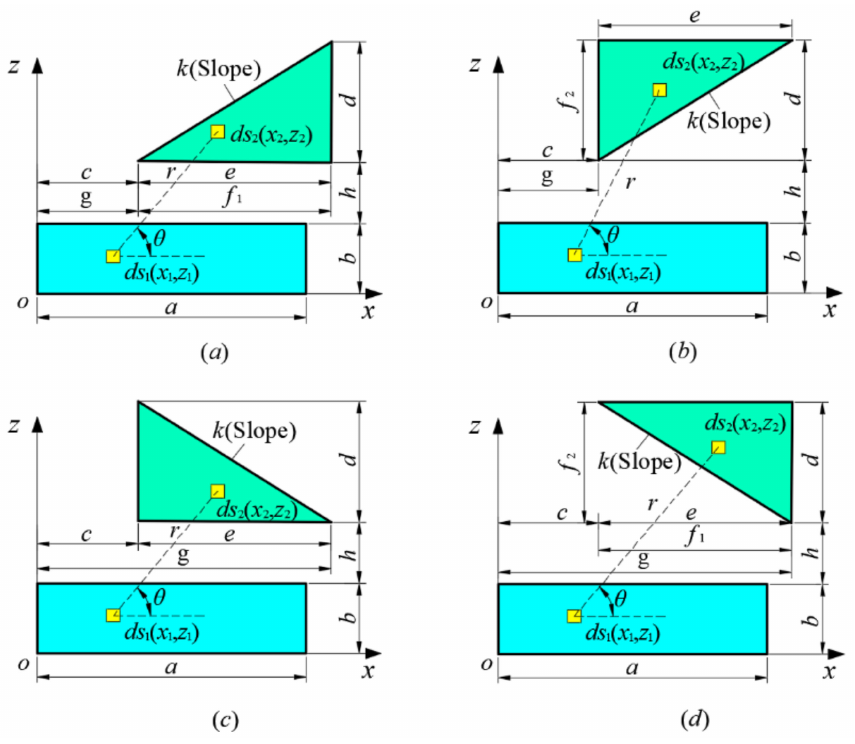
Figure 7. Schematic diagram of triangular–rectangular CPMUs.